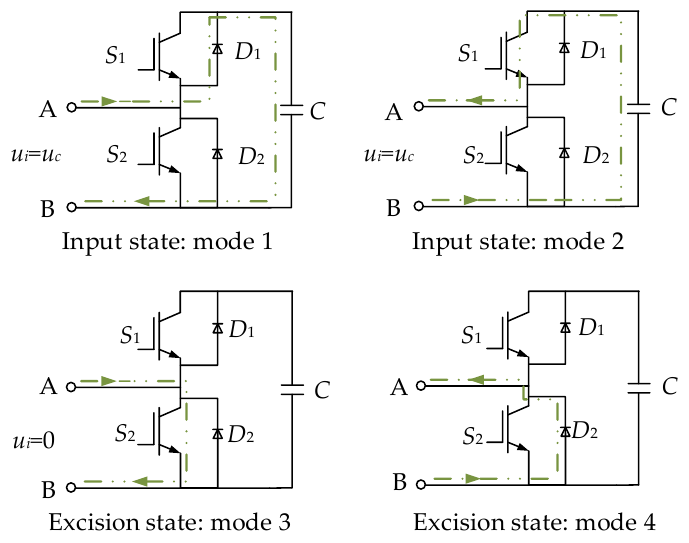
Figure 2. Normal operating state of the submodule.